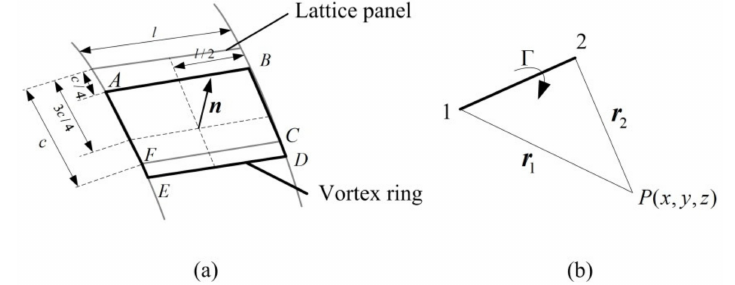
Figure 2. ( a ) Vortex ring and ( b ) induced